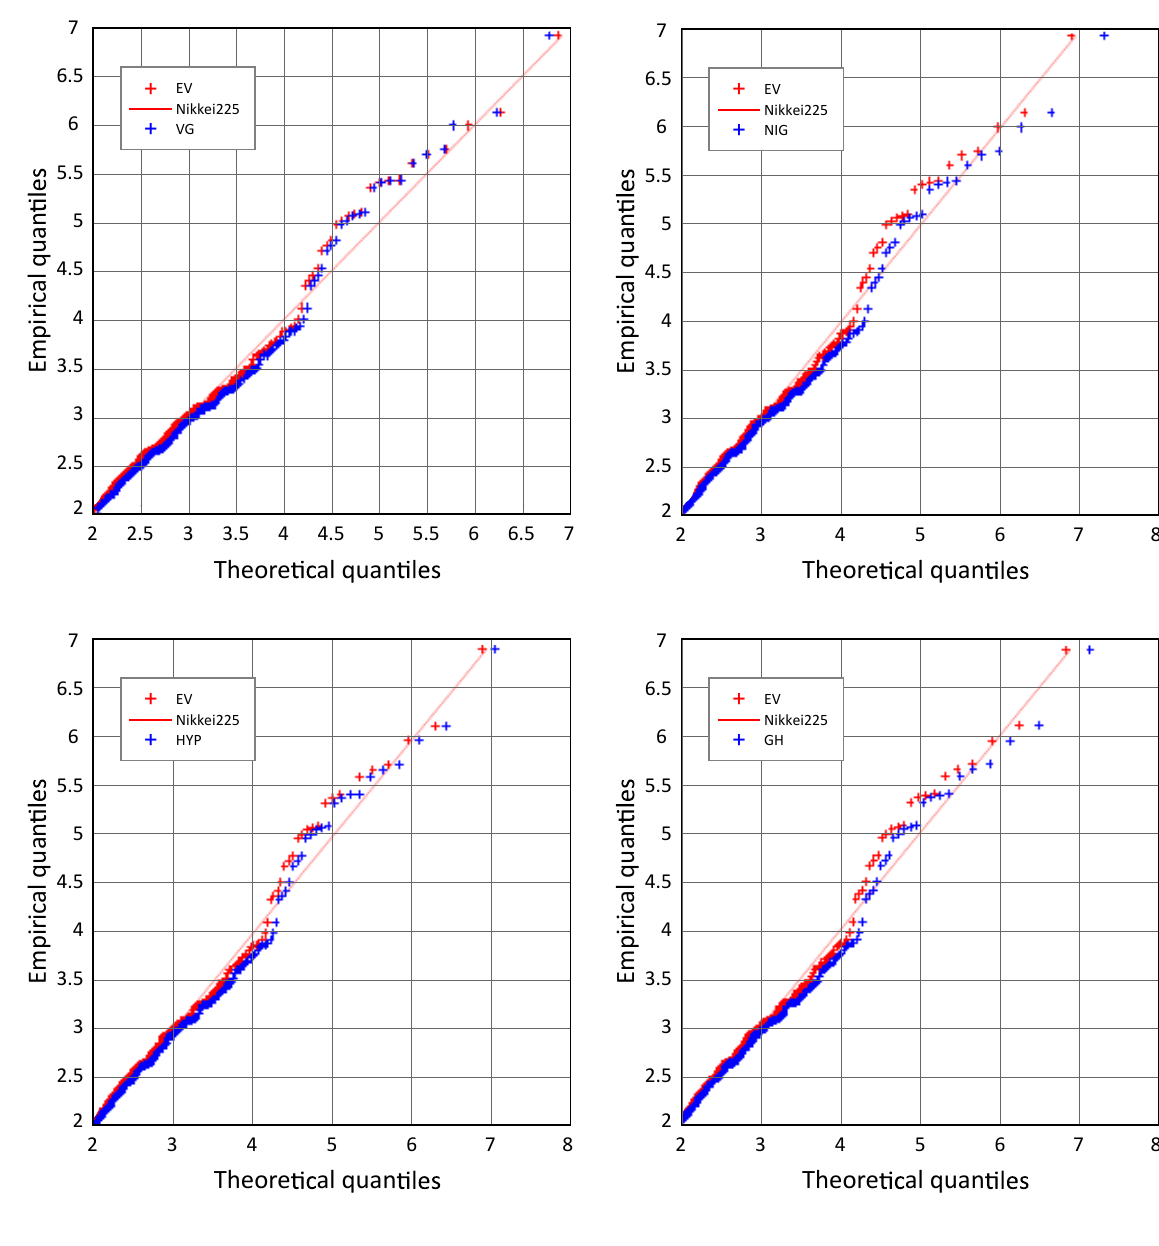
Figure 5. Conditional and unconditional quantiles in excess of threshold (2): long position in Nikkei